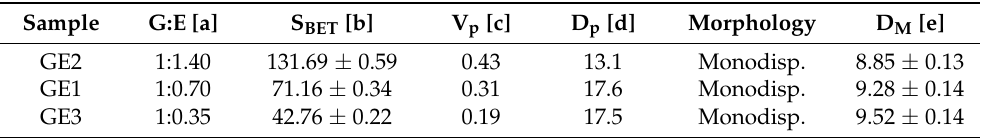
Table 1. Effect of crosslinker on morphology and porous structure.